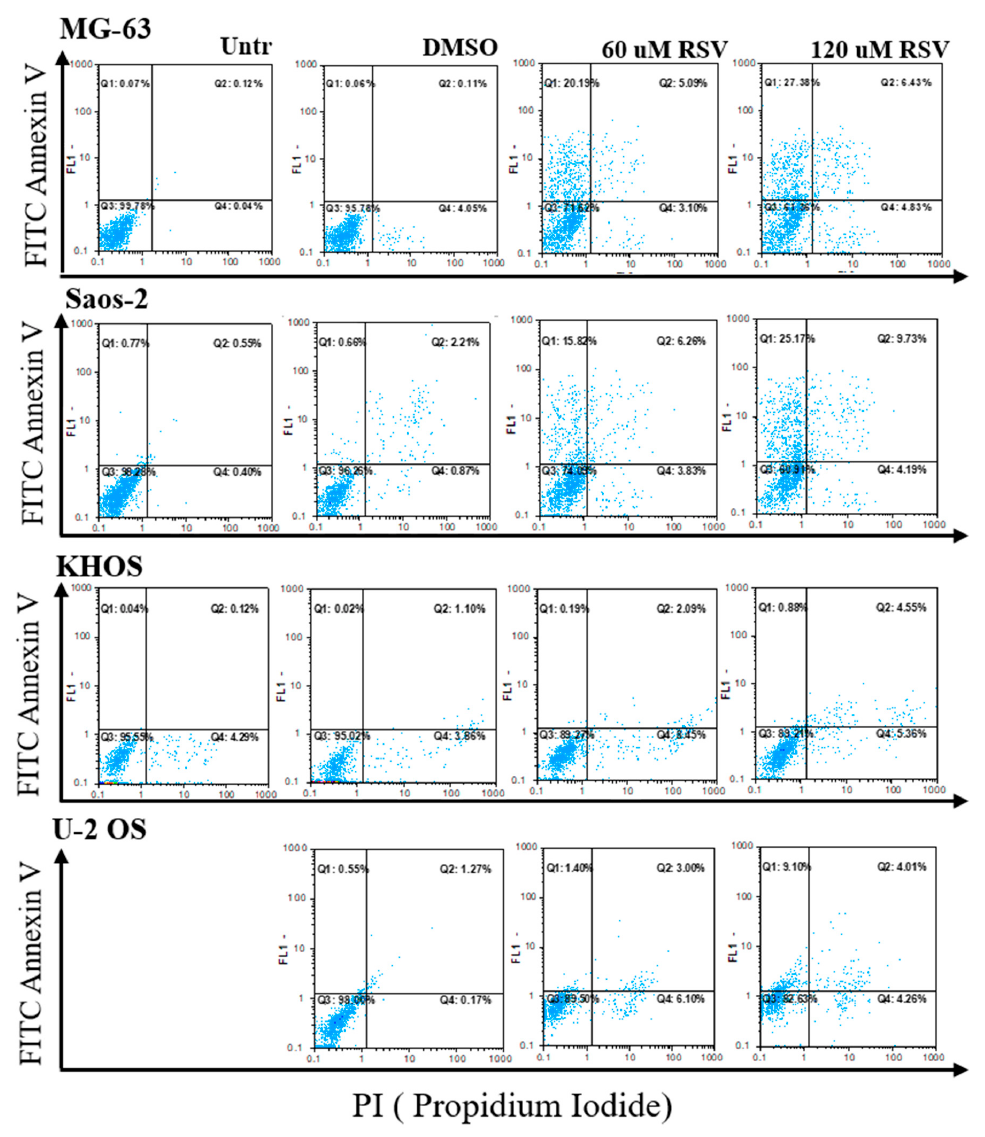
Figure 2. Results of annexin V/PI staining by flow cytometry analysis. For each OS cell line, the results of flow cytometry analysis are reported after 48 h of culture without any treatment (Untreated), or treated with DMSO, or with two different concentrations of RSV (60 or 120 µ M). The Q2 quadrant shows the percentage of double-stained cells for annexin V/PI and apoptotic cells. DMSO is the vehicle-related control of RSV and exhibits negligible effect on OS cell